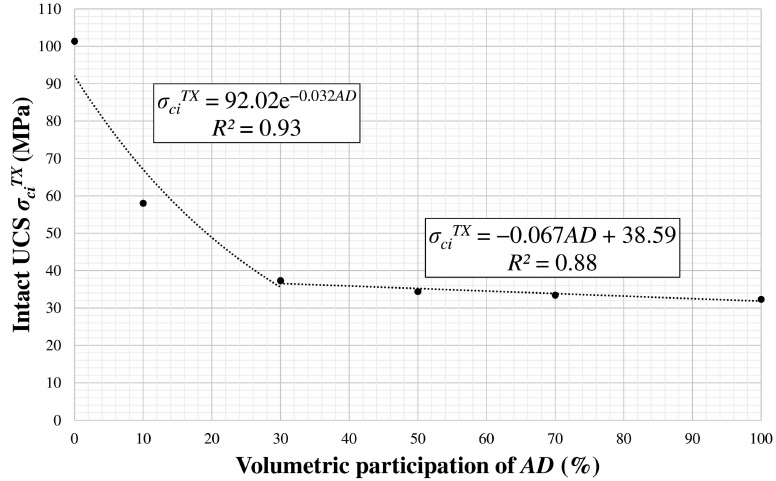
Figure 13. Values of intact UCS σ ciTX for different participation of AD